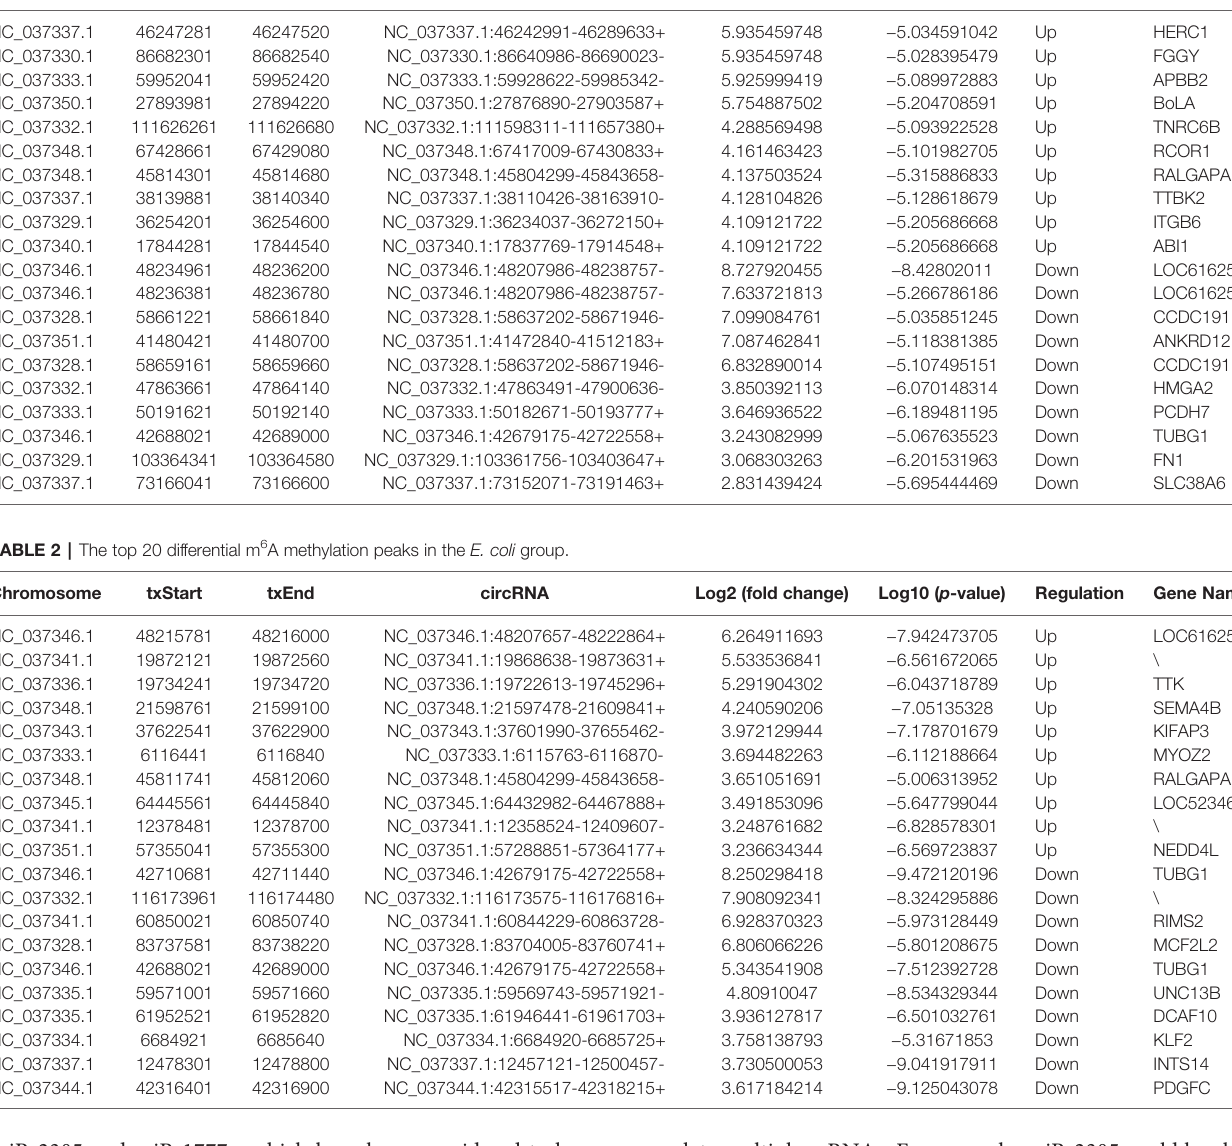
TABLE 1 | The top 20 differential m 6 A methylation peaks in the S. aureus group. Chromosome